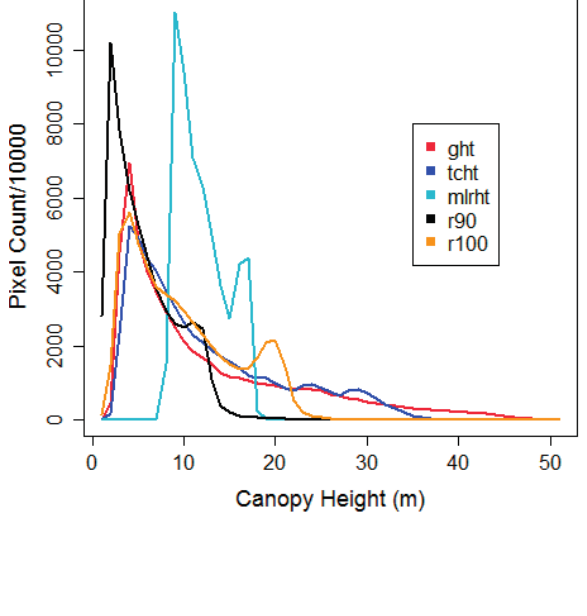
Figure 4. Plot showing the distributions of the five versions of GLAS-derived height: ght, tcht, mlrht, r90 and